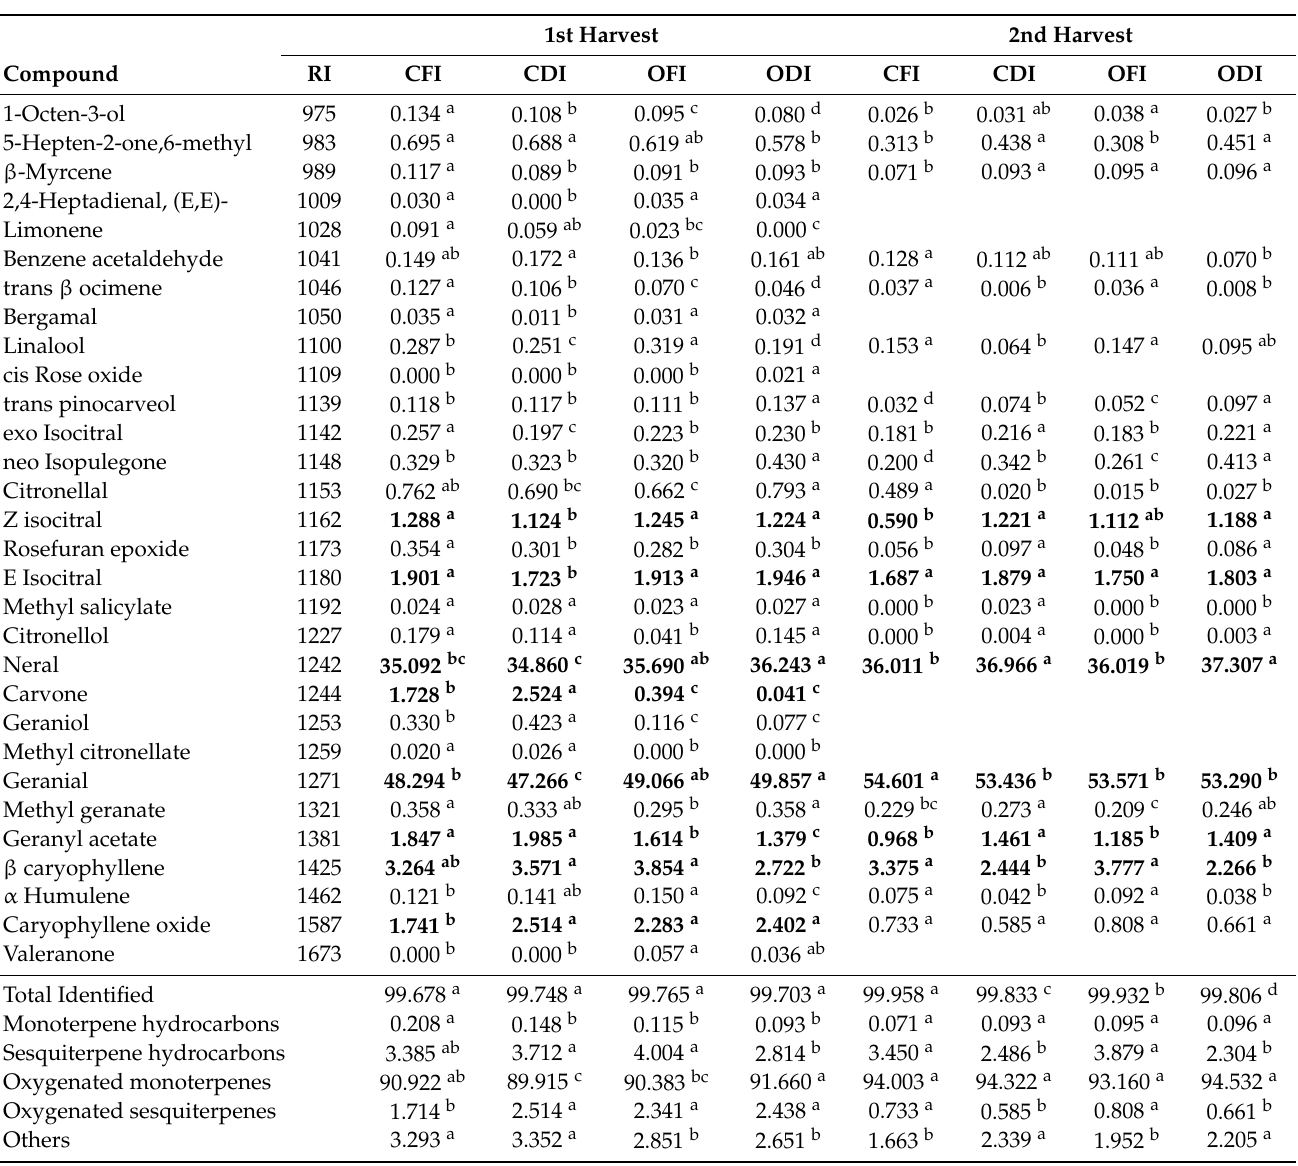
Table 4. Chemical composition (%) of essential oils of Melissa plants grown in conventional (C) or organic (O) cultivation systems and subjected to full (FI) or deficit (DI)